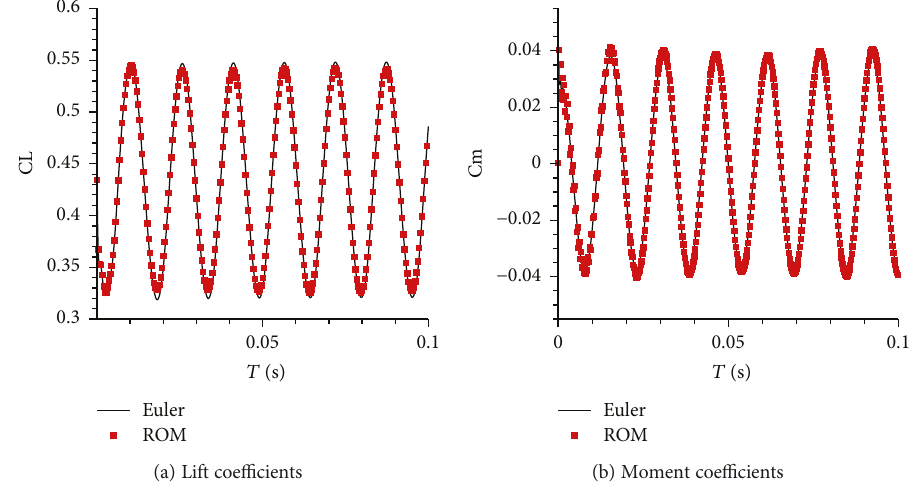
Figure 7: Comparison of the aerodynamic coe ffi cients obtained from Euler and ROM when f = 65